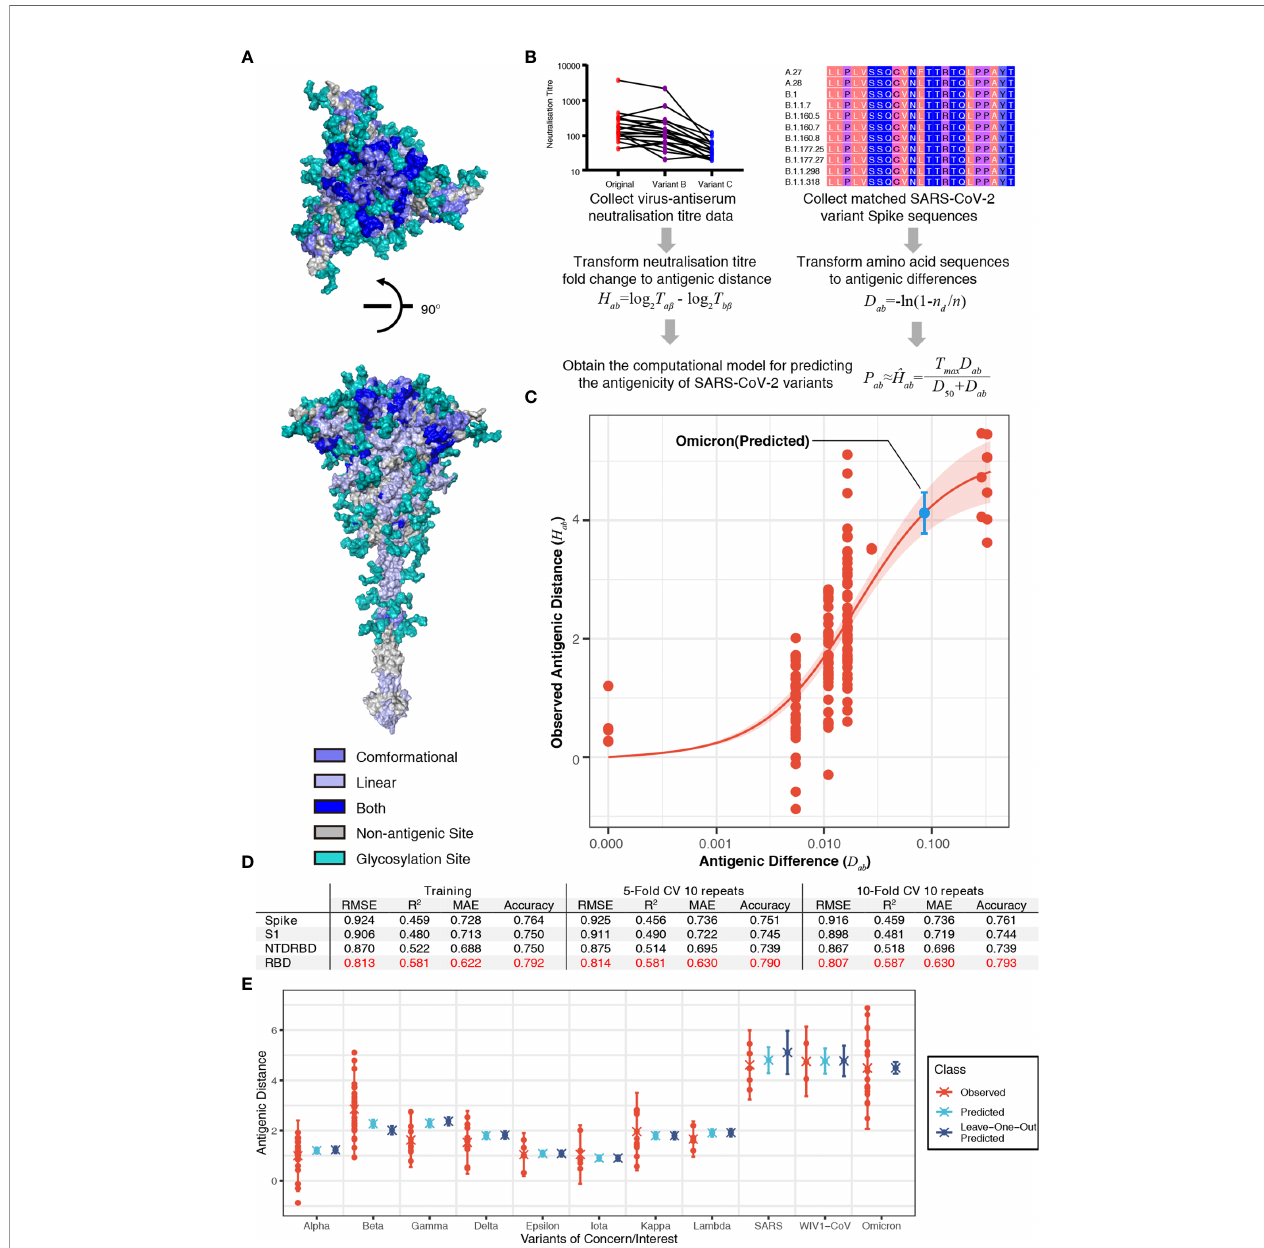
FIGURE 1 | Sequence-based prediction of antigenic distance. (A) The top view and the side view of antigenic sites on the full-length Spike protein (30). The conformational epitopes are colored in slate and linear epitopes in light blue. Some antigenic positions in both conformational epitopes and linear epitopes are colored in blue. All glycosylation sites are in teal. (B) A fl owchart of the process to establish the sequence-based computational model of severe acute respiratory syndrome coronavirus 2 (SARS-CoV-2) antigenicity. The antigenic distance of variant a to reference virus b from neutralization titer was de fi ned as H ab = log 2 T a b - log 2 T b b , where b , T a b , and T b b denote antiserum (referencing virus b ), the titer of antiserum b against virus b , and the titer of antiserum b against virus a ( 26 ) . The antigenic distance of variant a to reference virus b from amino acid sequences was de fi ned as D ab = - ln(1- n d / n ), where n d is the number of amino acid substitutions between variant a and reference virus b , n is the number of antigenic sites. Then, we proposed a relationship between the observed antigenic distance and the antigenic difference: H ab = T max ·D ab /( D 50 + D ab ), where T max is the maximal fold of decrease and D 50 is the antigenic difference that may lead to neutralization decrease at the 50% level of the maximal decrease. (C) The relationship between the antigenic difference and the observed antigenic distance. The predicted antigenic distance of B.1.1.529 (Omicron) is marked in cyan. (D) The performance of the model in different fragments of the spike protein in terms of root-mean-square error (RMSE), mean absolute error (MAE), coef fi cient of determination (R 2 ), and accuracy. (E) Predicted vs. observed antigenic distances of variants of concern. Here, the observed antigenic distances as fold decreases in the neutralization titers of variants of concern vs. the original strain on a log 2 scale. Each point shows the mean of antigenic distances in each assay. Predicted antigenic distances are based on the prediction in panel (C) Leave-one-out predicted antigenic distances are predicted based on the datasets without the variant that we aim to